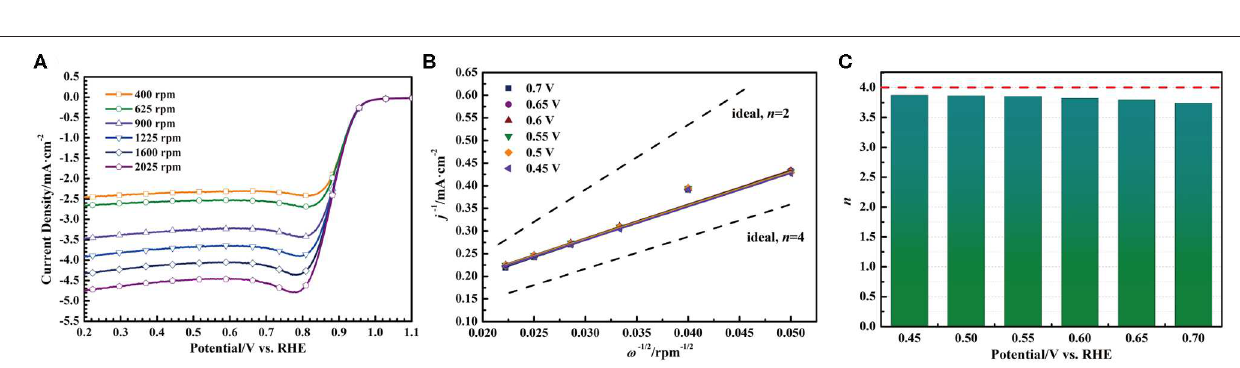
FIGURE 6 | (A) LSV curves of the S-Co-N/C-I with different rotating speeds, (B) the corresponding K-L plots, and (C) the corresponding electron transfer number.